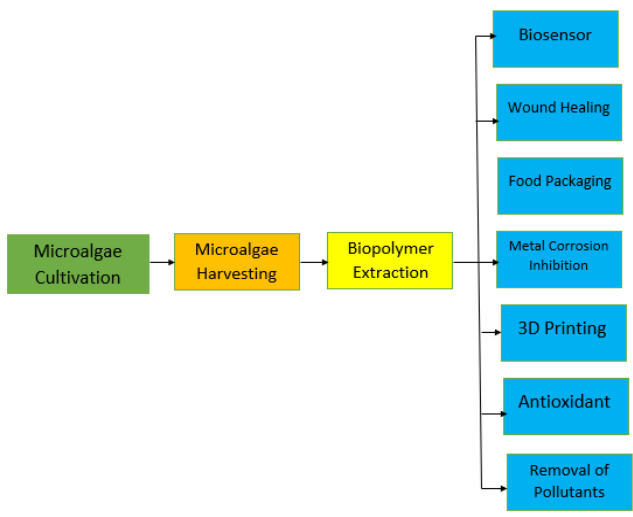
Figure 2. Applications of algal-driven biopolymers.